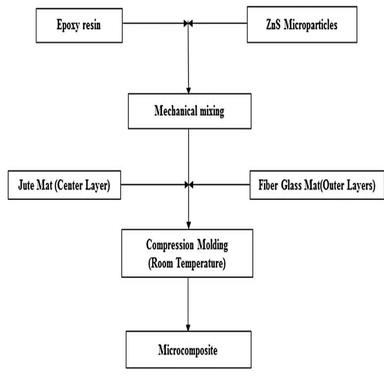
Methodology.